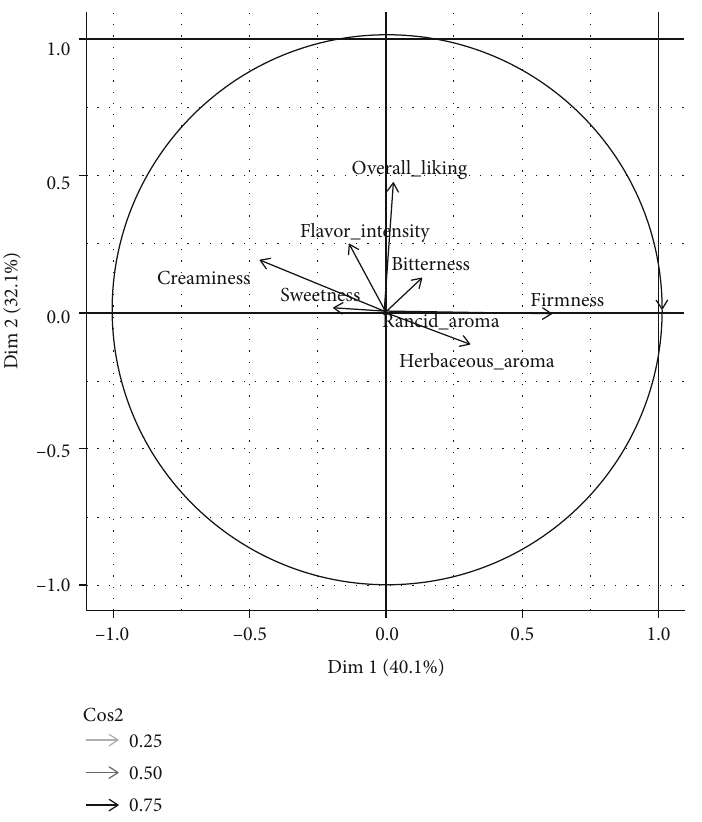
Figure 6: Biplot of sensory evaluation of di ff erent ready-to-eat avocado varieties, in dimensions 1 and 2.